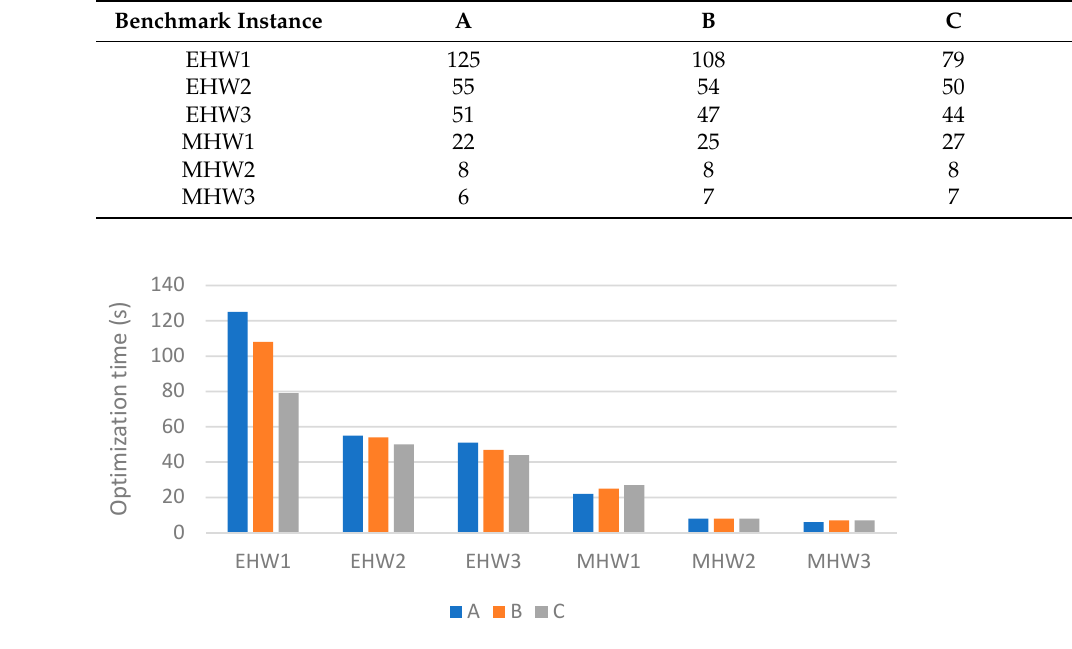
Figure 8. Average optimization time.